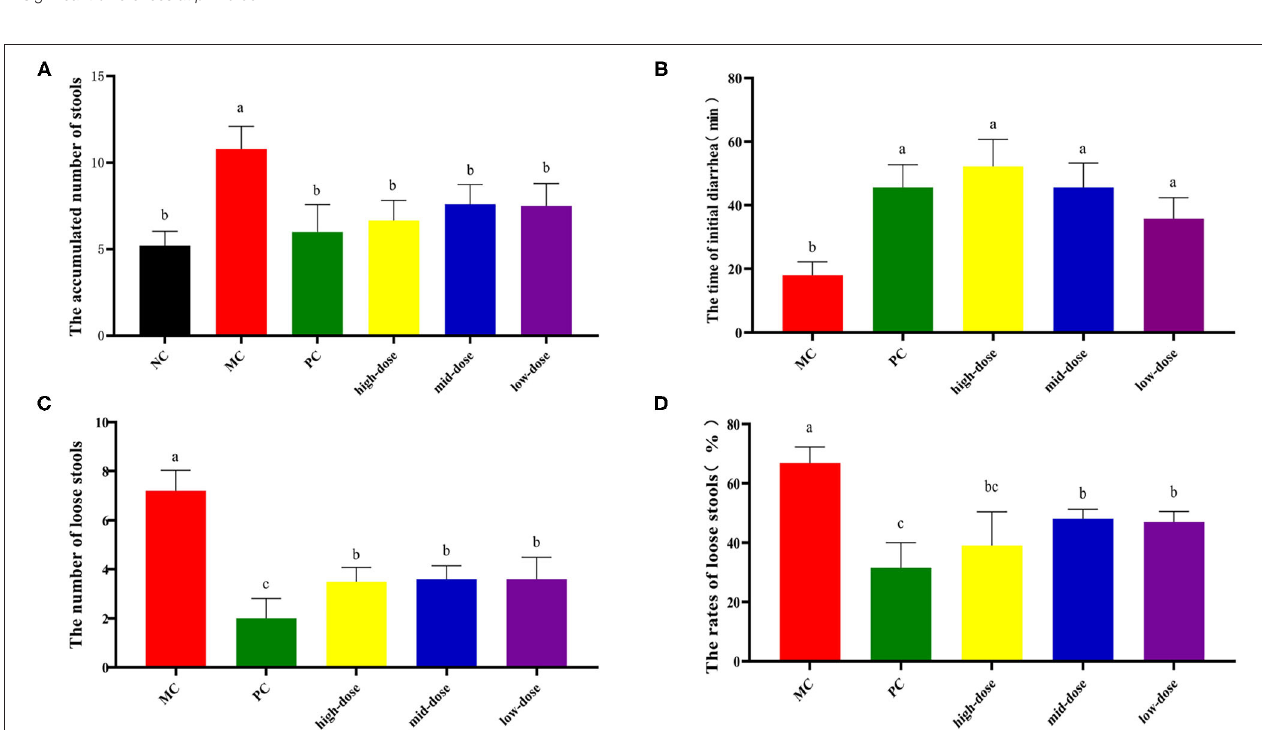
FIGURE 6 | Treatment of diarrhea mice with gradient dose of QJC. Data were expressed as the mean ± SD ( n = 5); the significant difference between groups ( p < 0.05) was shown by the different letters above the histogram. (A) The accumulated number of stools. (B) The time of initial diarrhea. (C) The number of loose stools. (D) The rates of loose